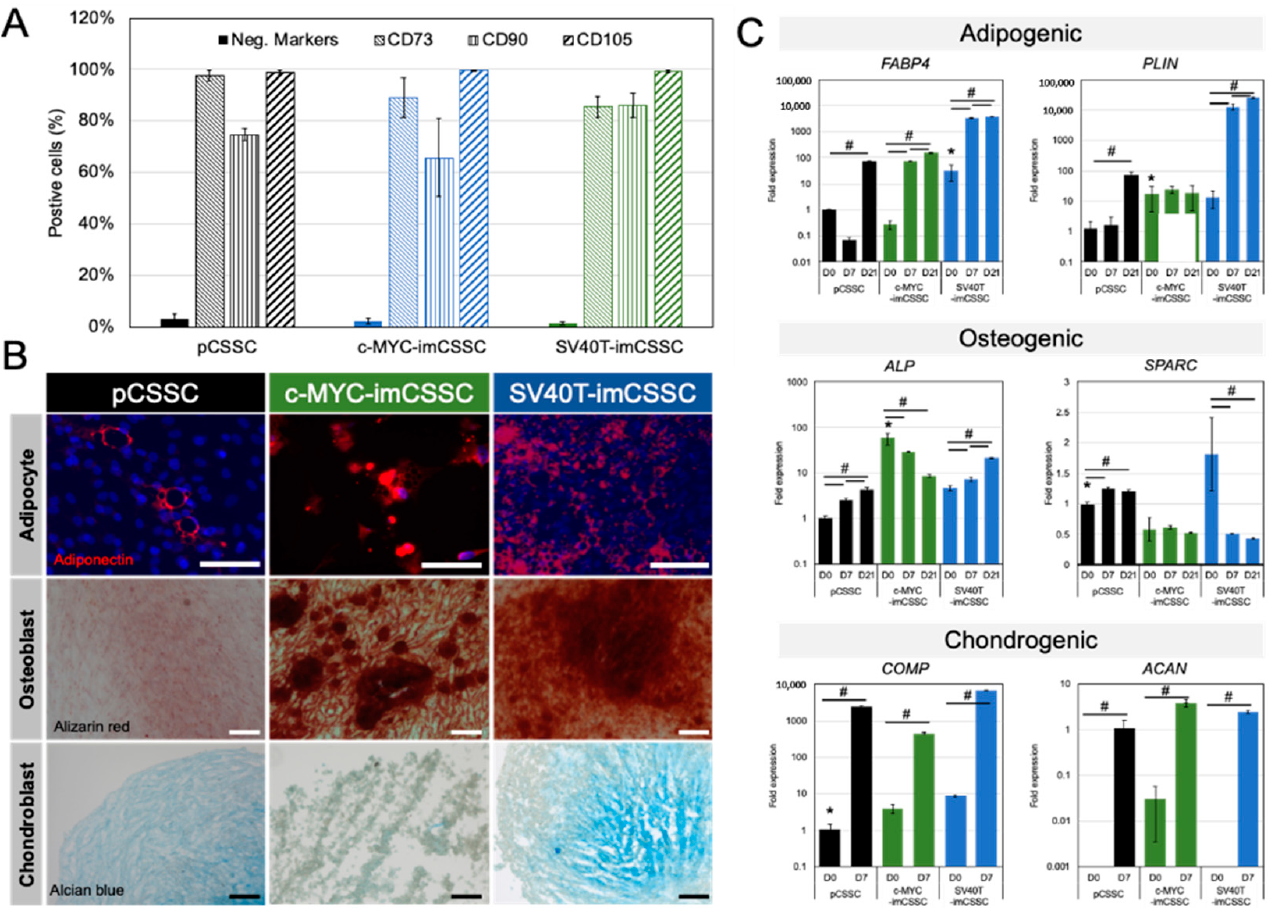
Figure 3. MSC phenotyping of pCSSC and imCSSC lines. ( A ) Analysis of MSCs’ surface antigens CD73, CD90, and CD105 and the negative markers (CD14, CD20, CD34, and CD45) was performed using flow cytometry (pCSSCs: p2 to 4; imCSSC: p7 to 12). Results are expressed as mean ± SEM. Statistical analysis: ANOVA test, not significant ( n = 6 for pCSSC, n = 4 for c-MYC-imCSSC and SV40T-imCSSC). ( B ) Multilineage induction were visualized by staining in pCSSC (p3) and imCSSC (p10 to 12) after 21 days of differentiation. Adiponectin immunofluorescence staining was used for adipocyte lineage. Alizarin red staining allowed visualization of calcium depositions (osteoblast induction). Chondroblast lineage induction was shown by Alcian blue staining marking chondrocyte- associated extracellular proteoglycans. Scale bar = 100 µ m ( C ) Multilineage differentiation of CSSC cell lines. Gene expression analysis of the adipose ( FABP4 and PLIN , top panel), osteogenic ( ALP and SPARC , middle panel), and chondrogenic markers ( COMP and ACAN , bottom panel) in each cell line tested by RT-PCR. Results are expressed as mean ± SD. Statistical analysis: ANOVA test, followed by all-pair comparisons Tukey’s. * p -value < 0.05 compared to pCSSC D0 (versus SV40T-imCSSC D0, c-MYC-imCSSC D0), # p -value < 0.05 compared to D0 (for each cell line). Scale bar: 100 µ m. Neg. markers: CD14, CD20, CD34, and CD45; CD: cluster of differentiation; CSSC: corneal stromal stem cell; pCSSC: primary CSSC; imCSSC: immortalized CSSC; SEM: standard error of the